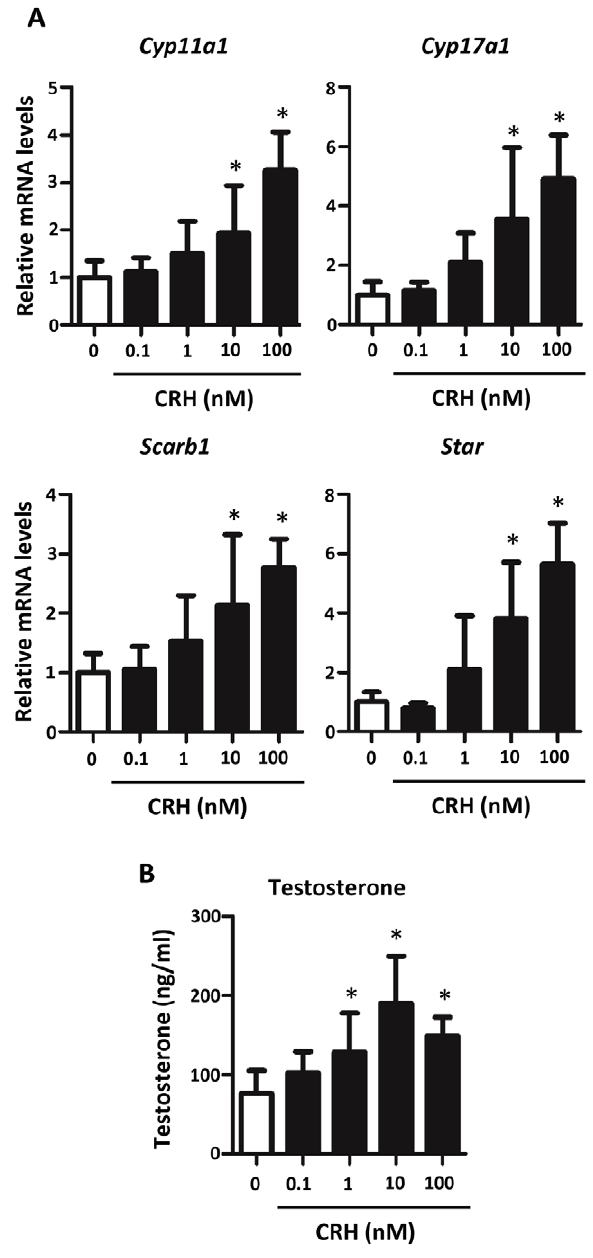
Figure 4. Effects of CRH on steroidogenesis in GD17 rat testis. A) Treatment with CRH increased steroidogenesis in GD17 rat testis. Seven to nineteen testes per group were exposed for 24 hours ex vivo. mRNA levels were determined using Taqman-based qRT-PCR. Mean 6 SD are shown for all data. Asterisk indicates significance for p-value of , 0.05 when compared with controls. B) Testosterone secretion increased in GD17 rat testis treated with CRH. Media were collected from eight to twenty samples per group for testosterone radioimmu- noassay analysis. Mean 6 SD is shown for all data. An asterisk indicates significance of a p-value ,